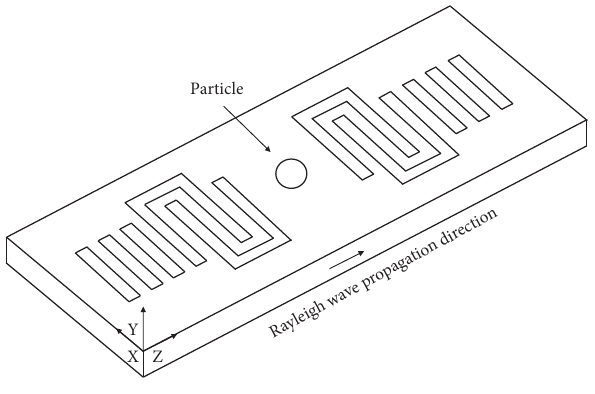
Figure 1: Particle-SAW interaction system.